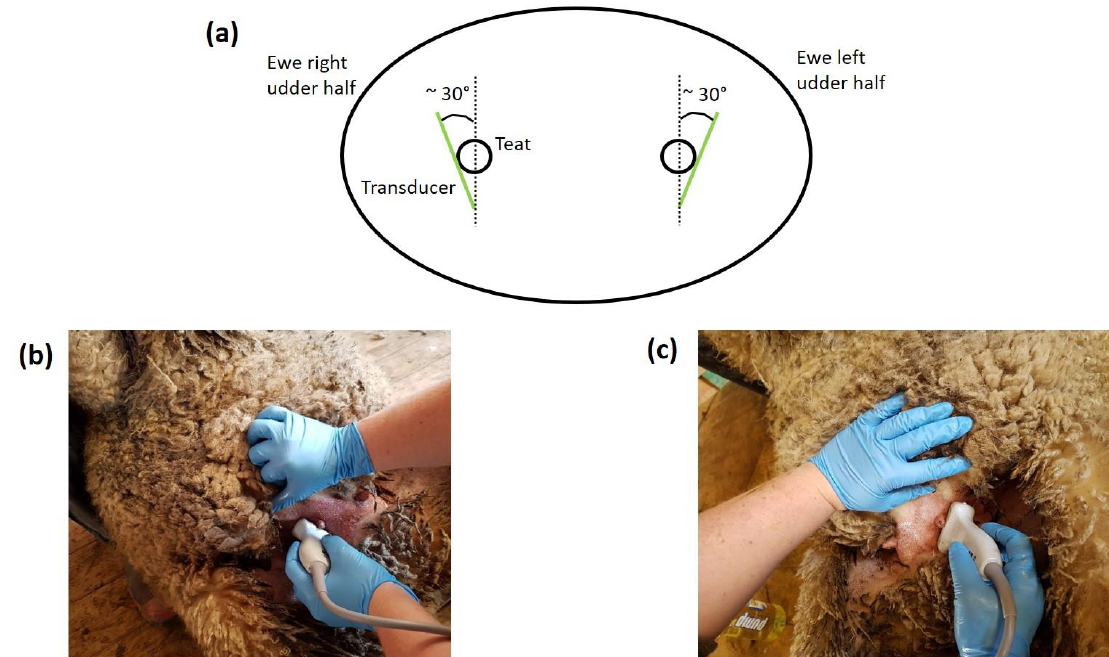
Figure 3. ( a ) Diagram representing the position of the transducer (solid line) applied on the right and left udder halves; ( b ) Picture of an ultrasound scan of the right udder half of a yearling ewe in pregnancy (P107); ( c ) Picture of an ultrasound scan of the left udder half of a yearling ewe in pregnancy (P107).